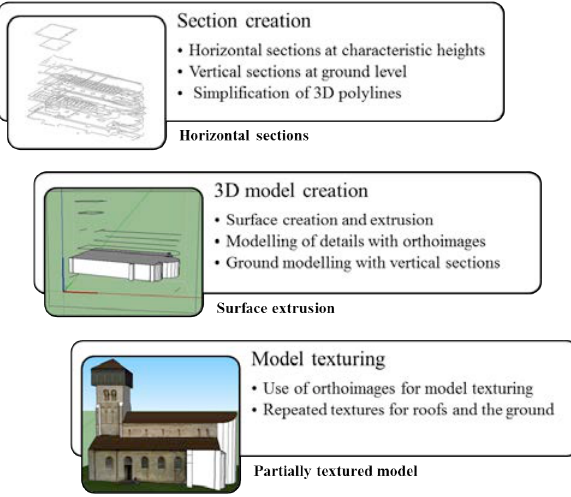
Figure 9. Workflow of 3D model creation